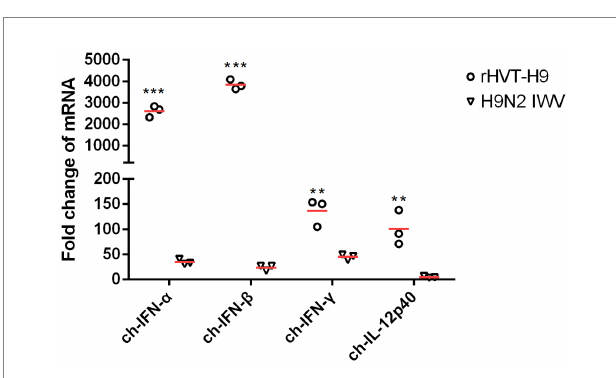
FIGURE 5 The mRNA expression of cytokines in splenocytes after vaccination in chickens with PTAs. Splenocytes of chickens with PTAs (n = 3/group) were collected twenty-eight-day after vaccination. Real-time PCR assay was used to detect the mRNA expressions of ch-IFN- α , ch-IFN- β , ch-IFN- γ and ch-IL-12p40. Student’s t -test was used to compare the differences in means between groups. Symbol (*) denotes differences between two groups (* p < 0.05, ** p < 0.01, *** p <